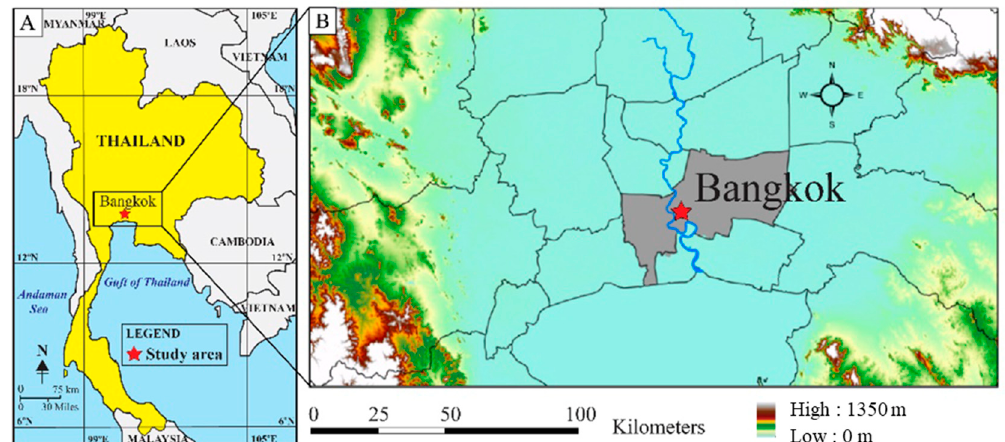
Figure 1. Location of the ground source heat pump (GSHP) experiment facility: ( A ) index map of Thailand; ( B ) Chulalongkorn University (star) in Bangkok. (Retrieved and modified from Chokchai et al. (2018) [11], Figure 1).